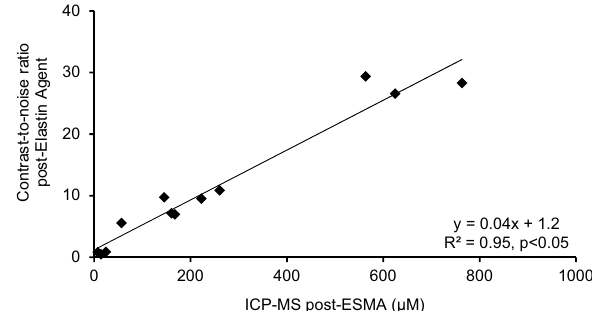
Figure 2. In vivo MRI signal measurements and ex vivo quantification of the elastin-specific probe in the periablational rim. Scatter plot shows a significant (p < 0.05) correlation between the contrast-to-noise ratios measured in the periablational rim and results from ICP-MS of liver tissue. This indicates a close association between the amount of in vivo binding of the elastin-specific molecular probe and the overall gadolinium detected in the ablated tissue. ICP-MS inductively coupled mass